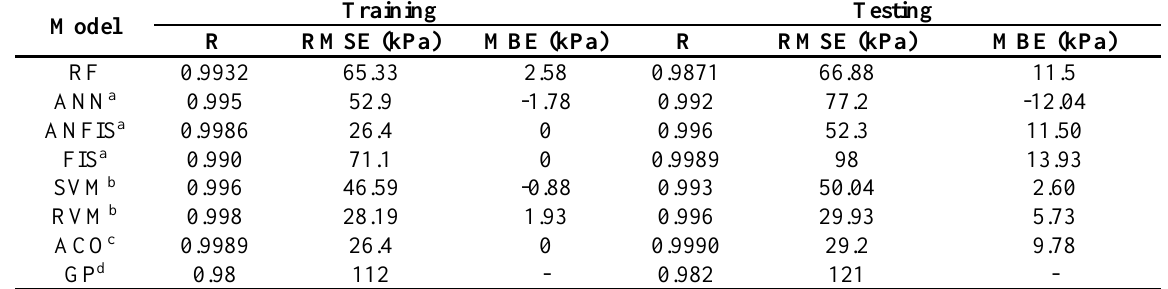
Table 6. Compression between RF model with other soft computing